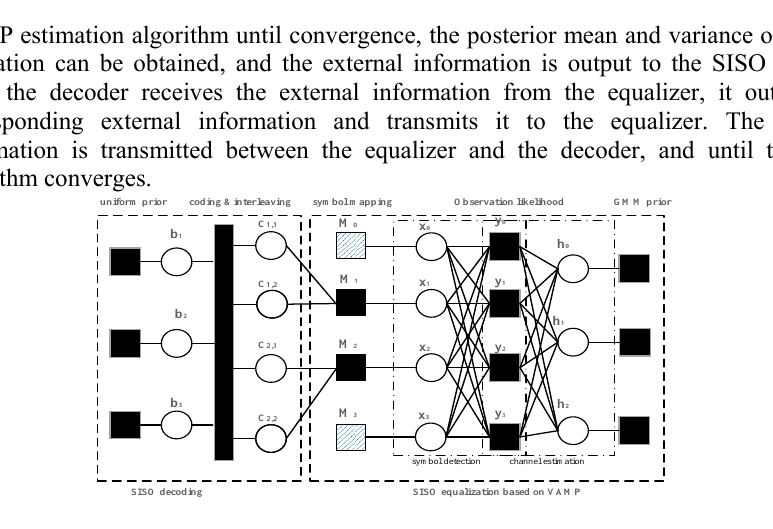
Fig. 3. Factor Diagram of SC-FDE System. There are two VAMP full connection subgraphs in the SISO equalizer, virtual box corresponding to symbol detection and channel estimation